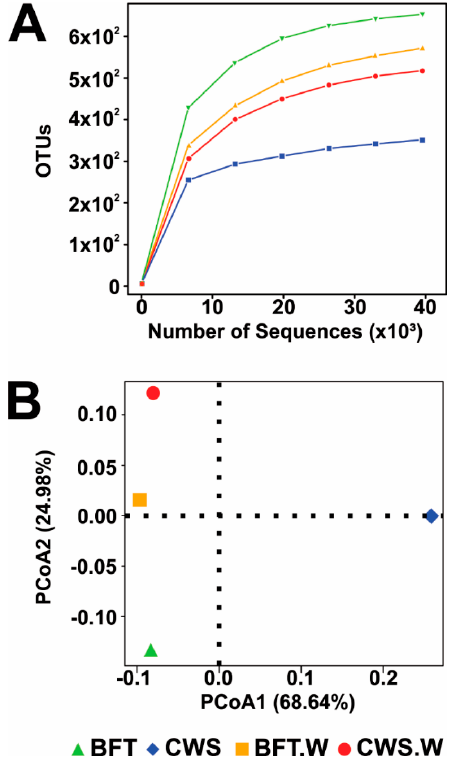
Figure 2. Sequencing coverage analysis by rarefaction curve ( A ) and Principle coordinate analysis ( B ) indicating the similarities and dissimilarities between bacterial communities present in the midgut of Litopenaeus vannamei reared in two different rearing systems (BFT: biofloc; CWS: clear seawater) and after an oral challenge by the White spot syndrome virus (BFT.W: shrimp reared in BFT and challenged by the WSSV; CWS.W: shrimp reared in CWS and challenged by the